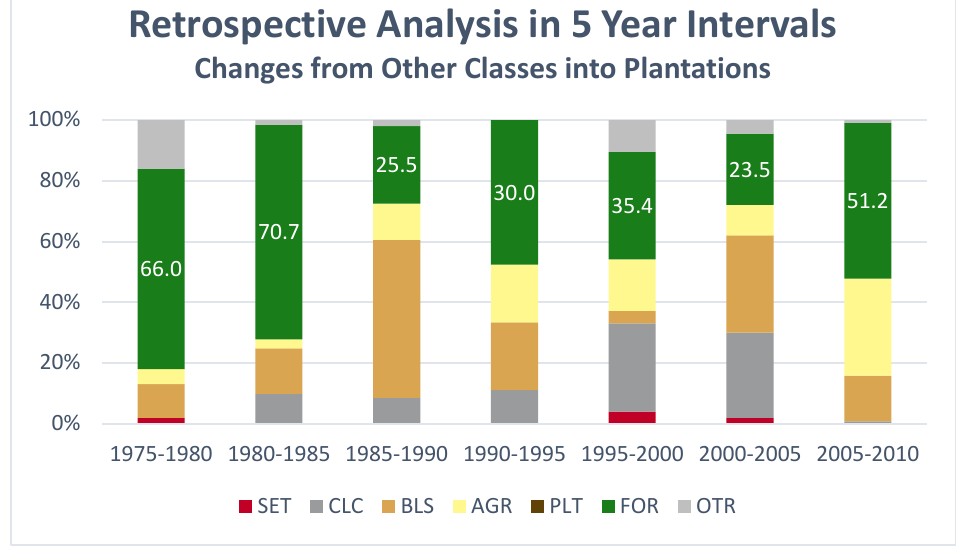
Figure 8. Retrospective analysis in five-year intervals focusing on plantations. Percentages show from which land use systems plantations have been established.